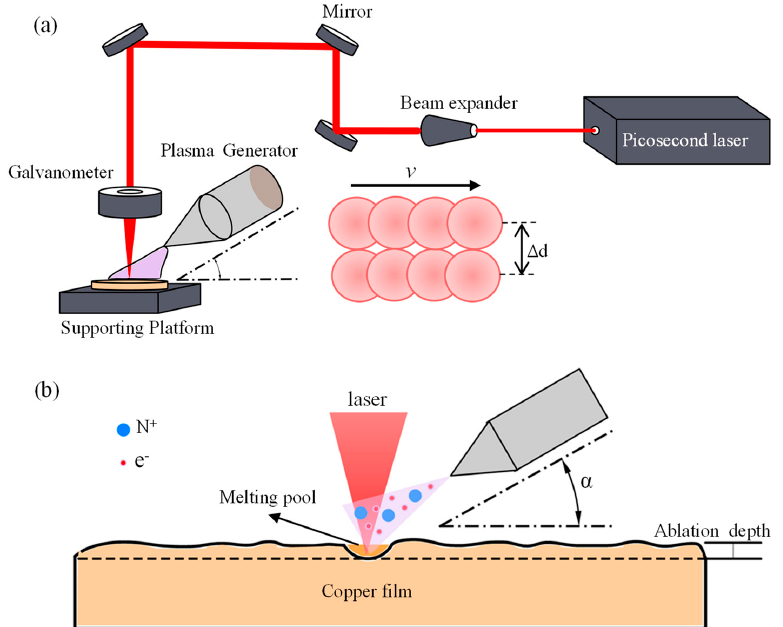
Figure 1. ( a ) Experimental schematic of Cu removal by nitrogen plasma − assisted ps-laser. ( b ) Mechanism of Cu removal by nitrogen plasma-assisted ps − laser.